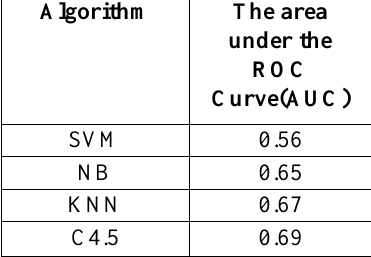
Figure 8. Correlation between Kidney disease and diabetic patients Diabetes mellitus and blood pressure frequently